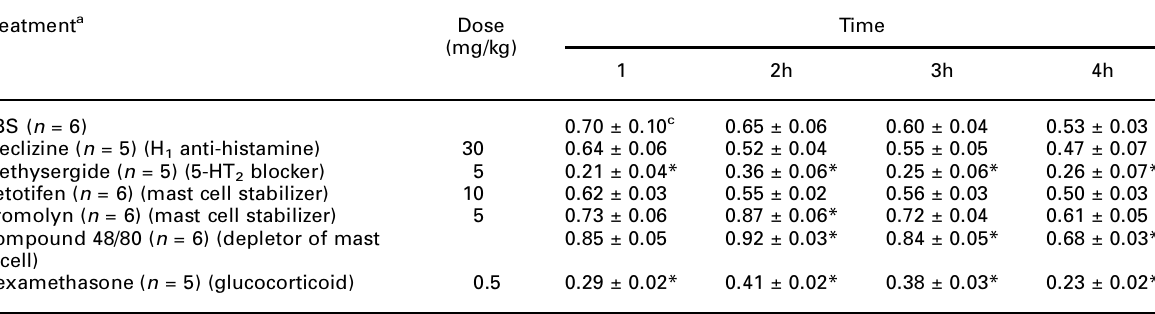
Table 2. Effect of anti-histamine and anti-allergic drugs on the time course of paw oedema induced by OVA in sensitized rats Treatment